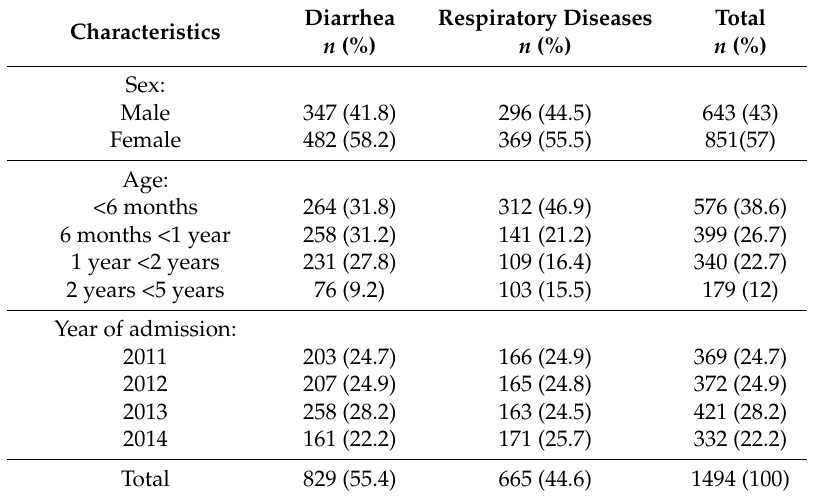
Table 2. Characteristics of children admitted due to diarrhea and/or respiratory diseases ( n = 1494).